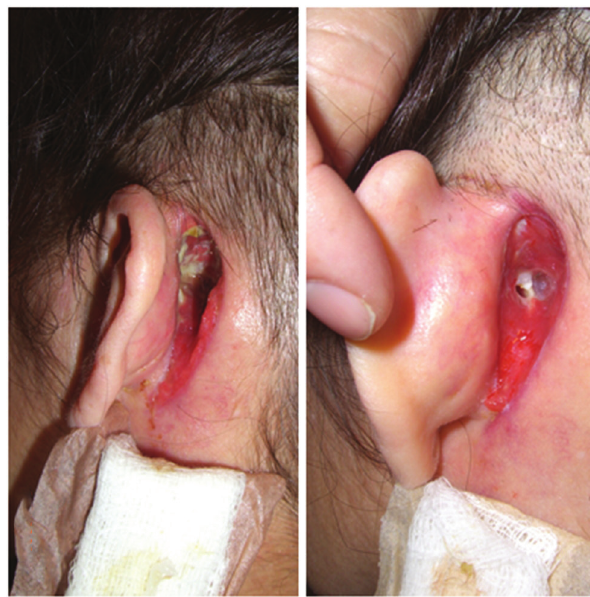
Figur 1 Dehiscent retroauricular incision. Left image: aspect 80 days after surgery; and on the right: 30 days after start of treatment for tuberculosis, showing improved